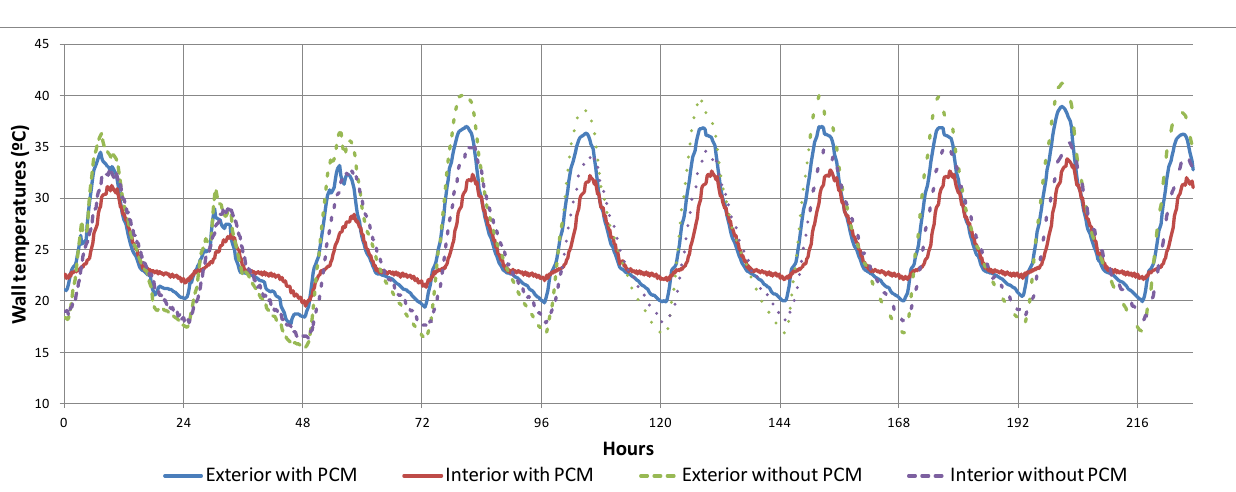
Figure 13. Predicted temperatures of the south wall of the cubicle in the simulation with and without PCM.